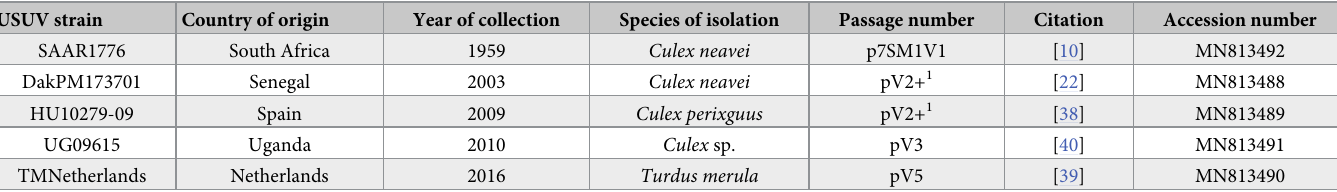
Table 1. USUV isolates used in this